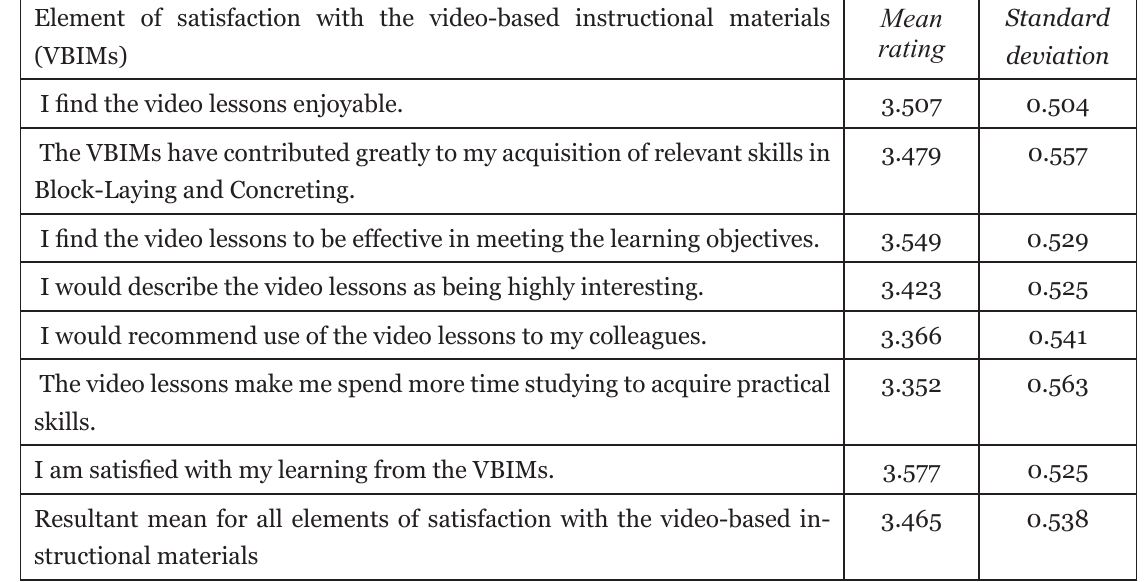
Table 3 Descriptive Statistics of Learners’ Rating of Satisfaction with Video-Based Instructional Materials Element of satisfaction with the video-based instructional